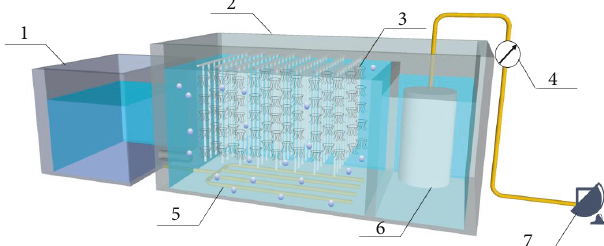
Figure 1: Schematic of the bio fi lm-membrane bioreactor. 1: regulating tank; 2: bio fi lm-membrane bioreactor; 3: bio fi lm carrier; 4: pressure meter; 5: perforated aeration pipes; 6: membrane module; 7: drainage